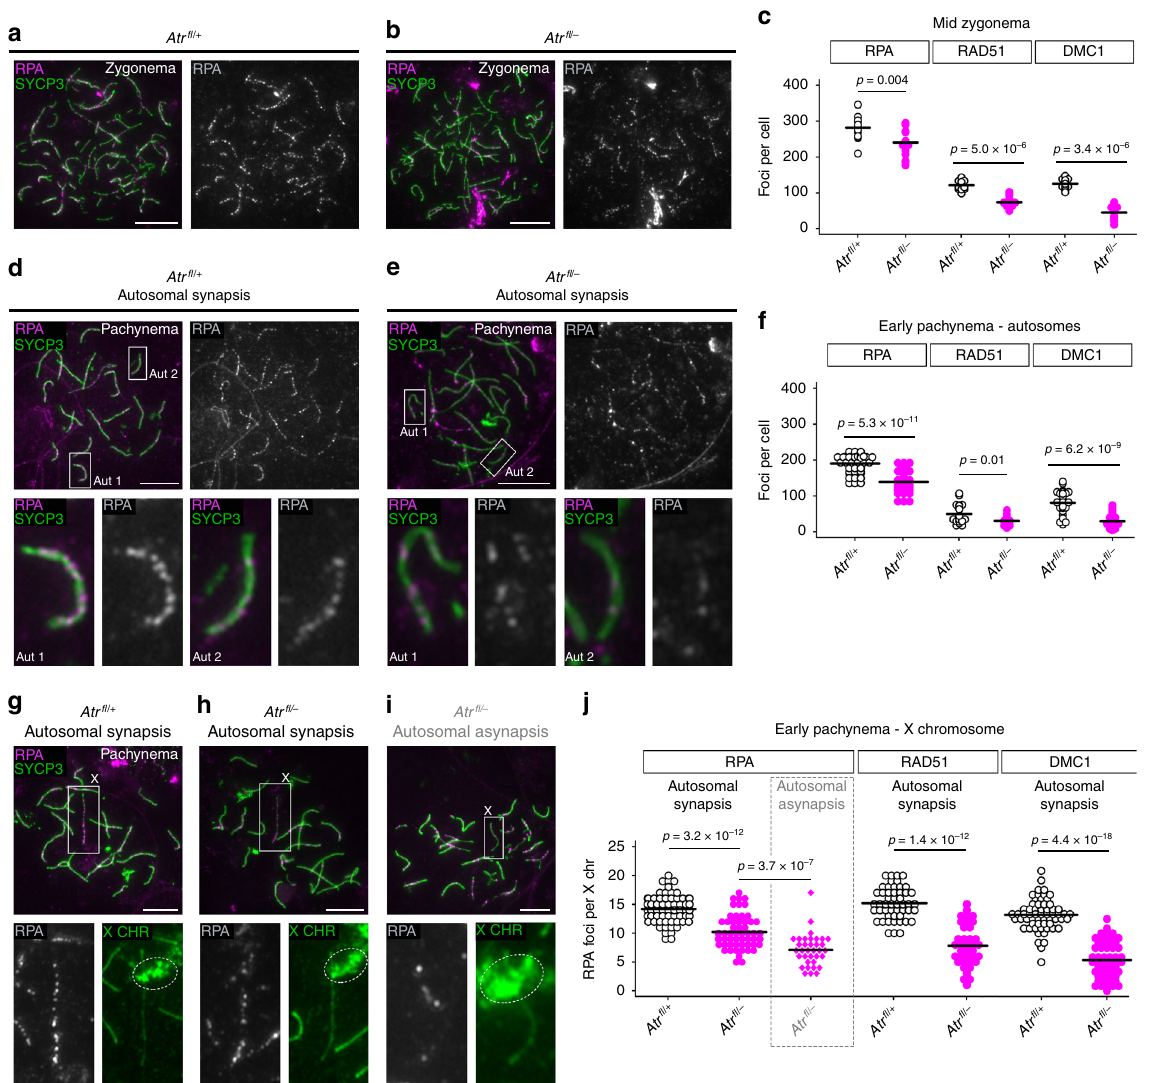
Fig. 5 ATR regulates DSB marker counts during zygonema and pachynema. a , b RPA (magenta) and SYCP3 (green) immunostaining in Atr fl / + and Atr fl / – males. c RPA, RAD51 and DMC1 counts at mid zygonema in Atr fl / + males ( n = 2 males; 16 cells for RPA, 15 cells for RAD51, 15 cells for DMC1) and Atr fl / – males ( n = 2 males; 16 cells for RPA, 15 cells for RAD51, 15 cells for DMC1). d , e Examples of early pachytene cells from Atr fl / + and Atr fl / – males with normal autosomal synapsis. Two representative autosomes (aut 1 and 2) are boxed in upper panels and magni fi ed in lower panels. f autosomal RPA, RAD51 and DMC1 counts at early pachynema in Atr fl / + males ( n = 2 males; 49 cells for RPA, 19 cells for RAD51, 33 cells for DMC1) and Atr fl / – males ( n = 2 males; 43 cells for RPA, 19 cells for RAD51, 35 cells for DMC1). g , h Early pachytene Atr fl / + and Atr fl / – cells with normal autosomal synapsis and the X chromosome (boxed in upper panels) identi fi ed by Slx DNA FISH (dashed circles in lower panels). i Early pachytene Atr fl / – cell with autosomal asynapsis. j X-chromosome RPA, RAD51 and DMC1 counts at early pachynema in Atr fl / + males ( n = 2 males; 64 cells for RPA, 49 cells for RAD51, 59 cells for DMC1) and Atr fl / – males ( n = 2 males; 62 cells for RPA in autosomal synapsis category, 35 cells for RPA in autosomal asynapsis category, 36 cells for RAD51, 53 cells for DMC1). Mean and p values (Mann – Whitney test) indicated. Scale bars 10 µ